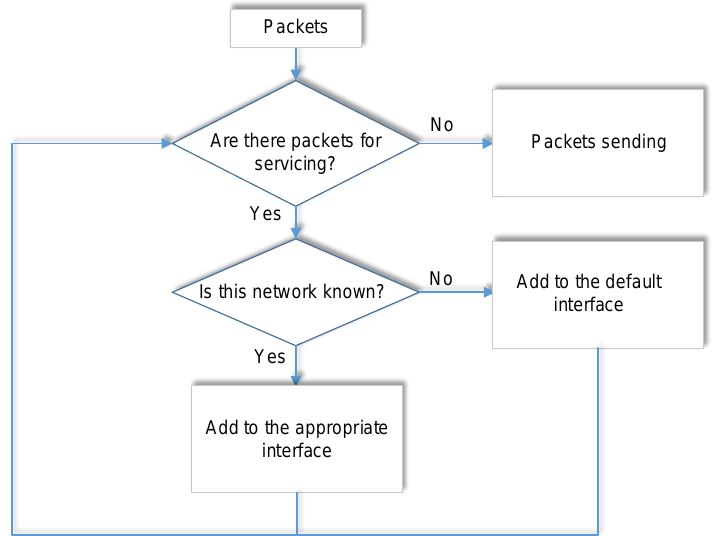
Figure 13. Packet routing algorithm.